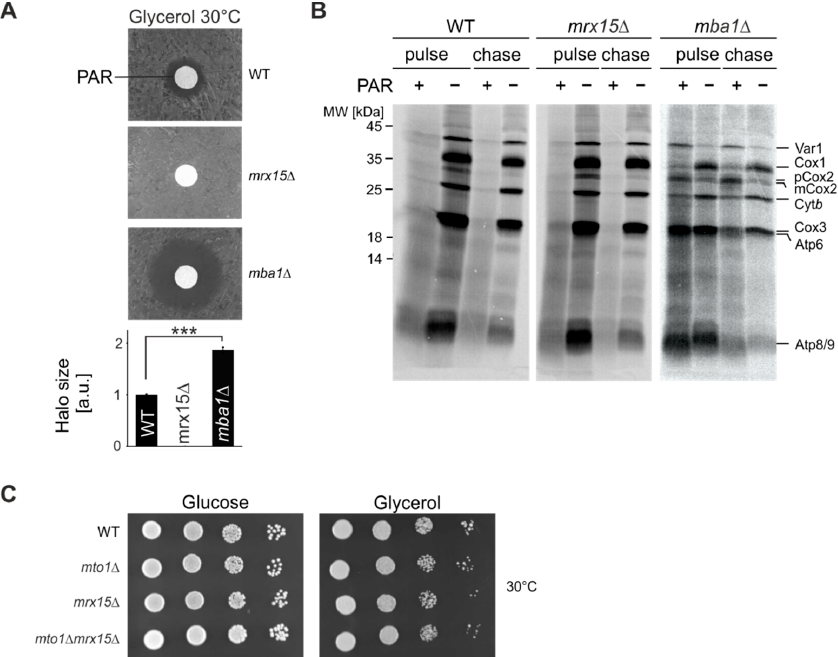
Figure 1. Mba1 and Mrx15 fulfil opposite roles in proteotoxic stress resistance. ( A ) Disk diffusion assay of indicated strains. Sensitivity against 1 mM paromomycin (PAR) was tested by plating cells on respiratory growth media (glycerol) and adding the antibiotic. Halo diameters of 3 independent experiments were quantified. Significance of observed changes was assessed by a student’s t -test (*** p ≤ 0.001). ( B ) In organello radiolabeling in the presence of paromomycin. Isolated mitochondria of indicated strains were incubated 30 min with 1 mM paromomycin. Afterwards, mitochondrial translation products were labelled for 20 min and the stability checked 30 min after synthesis. As control, the reaction was performed without the antibiotic. ( C ) Cells were spotted in serial 10-fold dilutions on solid media containing fermentable (glucose) or non-fermentable (glycerol) carbon sources and incubated at 30 ◦ C. WT,